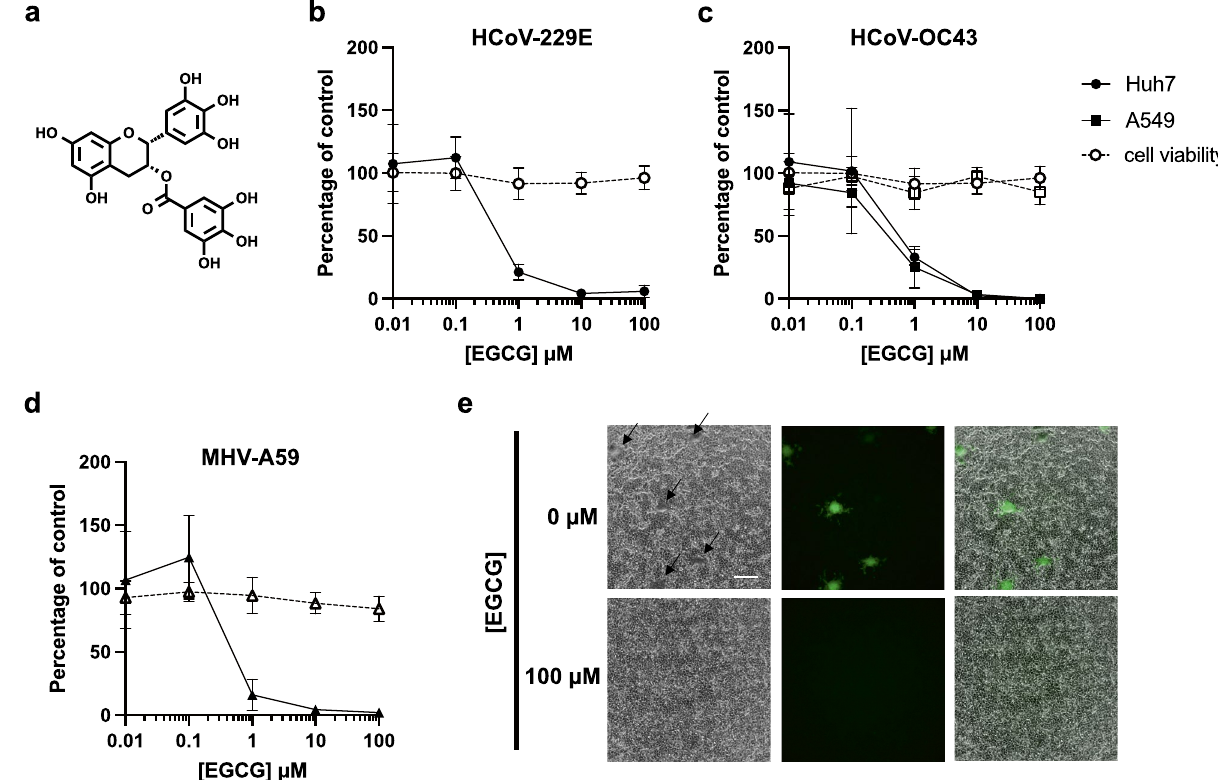
Figure 1. EGCG pre-treatment inhibits infection by diverse CoVs without affecting cell viability. ( a ) Structure of epigallocatechin gallate (EGCG). ( b-d ) Pre-treatment of authentic HCoV-229E, HCoV-OC43 or murine coronavirus MHV-A59-GFP virions with EGCG for 10 min at 37 °C inhibits infection of Huh7 (b,c) , A549 (c) or L929 cells (d) , respectively. Mean values with standard deviation from three independent experiments are plotted. Cell exposure to EGCG during the 2 h infection had minimal effect on cell viability (dashed line), where mean values with standard deviation of two independent experiments with duplicates are plotted. ( e ) A reduction in syncytia (black arrows) was observed for EGCG-treated MHV-A59. Scale bar: 200